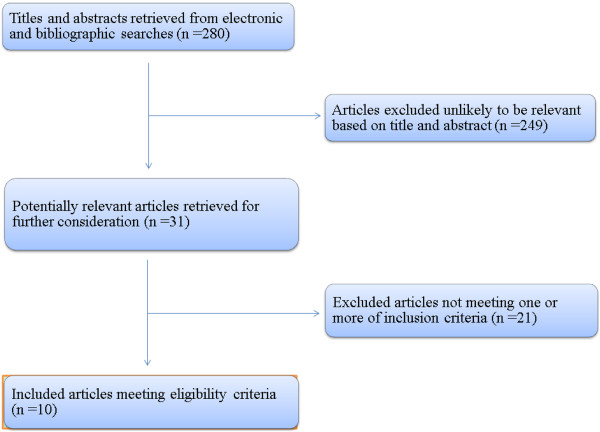
Selection of included trials.